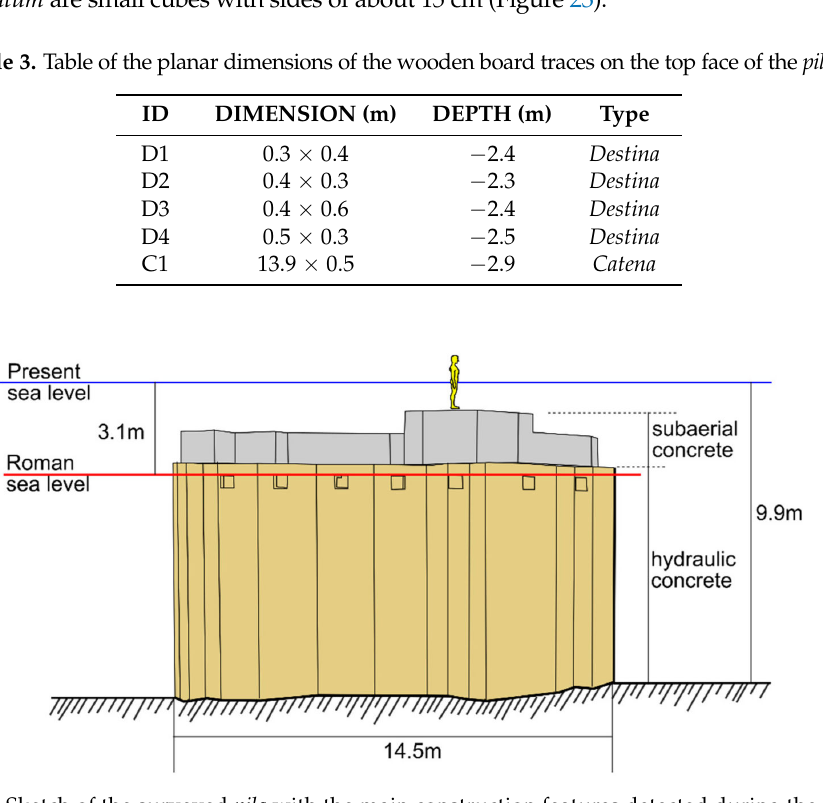
Figure 20. Sketch of the surveyed pila with the main construction features detected during the surveys and with the Roman sea level position here